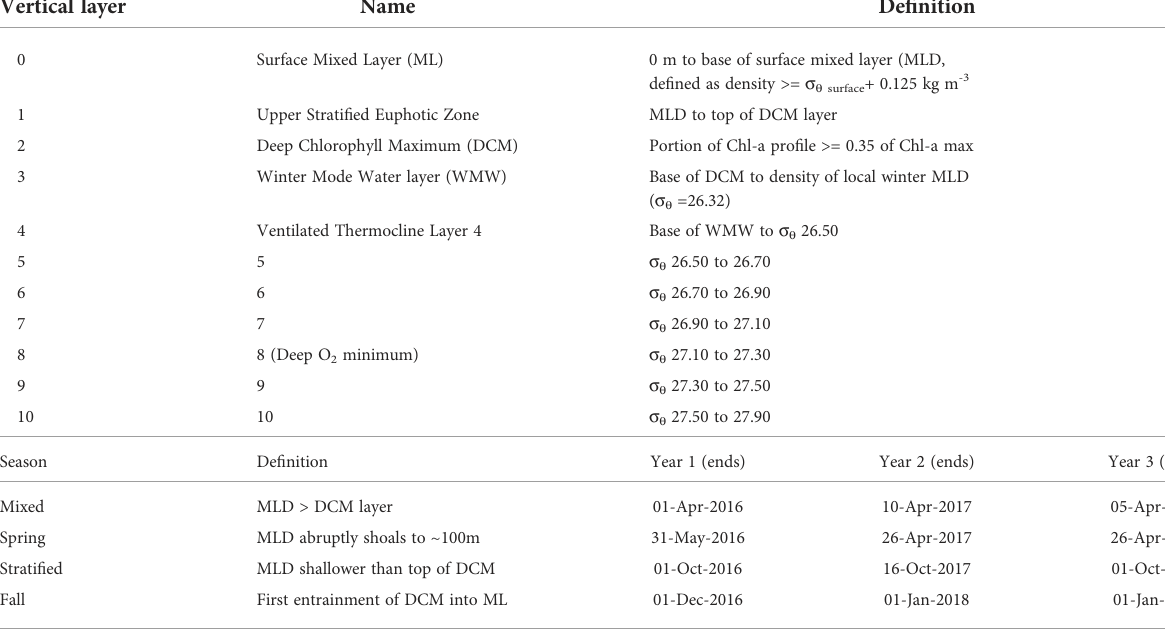
TABLE 1 Hydrographic envelope for the hydrographic layers and season de fi nitions. Vertical layer